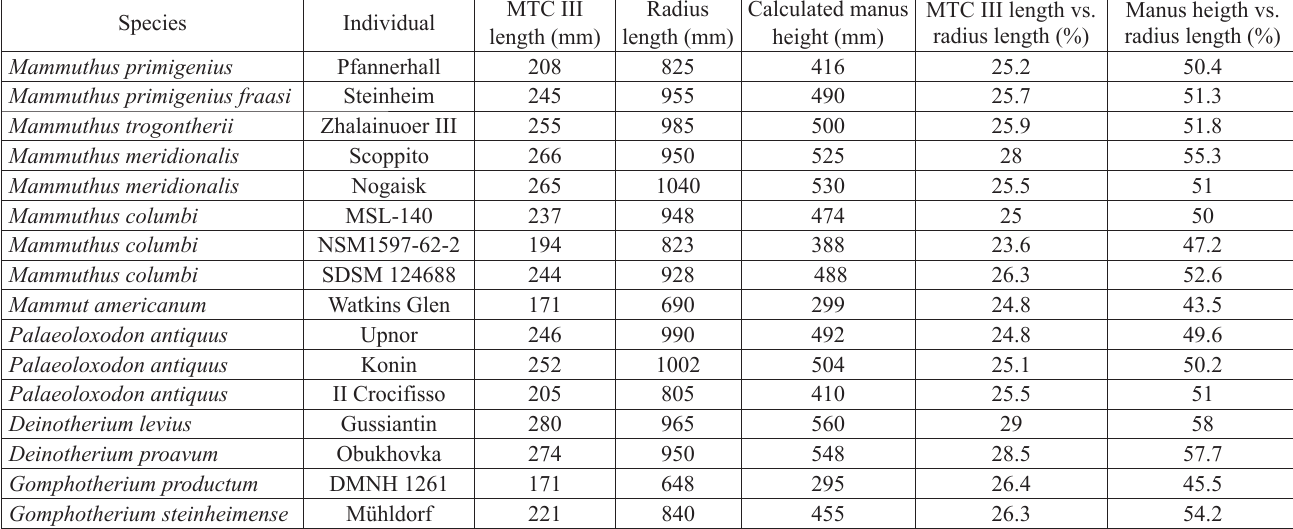
Table 2. Ratios between metacarpal (MTC) III length vs. radius length and manus height vs. radius length of different proboscidean species. Skeletal manus heights are calculated based on the ratios obtained from Table 1 and Appendix 1, where the manus height vs. MTC III ratio is very close to 2 in case of derived proboscideans and deinotheres, and 1.75 in case of most